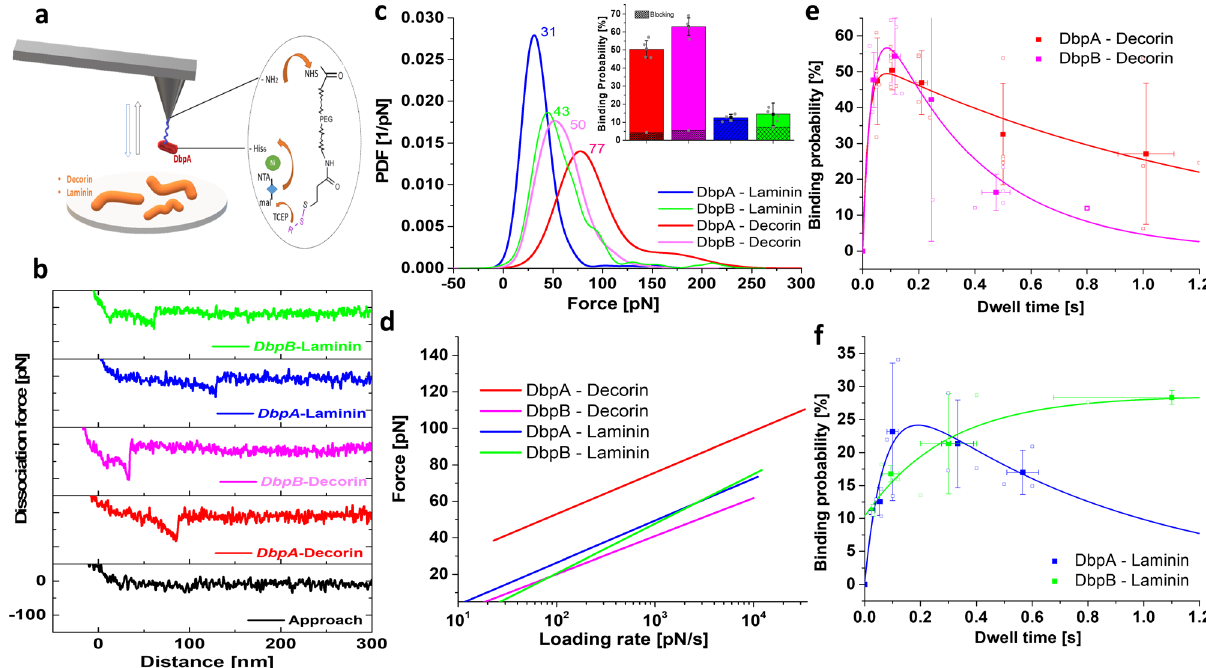
Fig. 3 Single molecular Dbps/ECM bond analysis reveals force-tuned dissociation paths. a Scheme of the immobilization strategy of decorin binding protein coupled to an amino-functionalized AFM tip end via a heterobifunctional PEG linker, and attachment of extracellular matrix protein onto a silicon substrate. b typical force – distance curves obtained by SMFS, from which the dissociation forces (visible as spike at about 50 – 150 nm distance) of individual Dbps/ECM bonds were measured. Dissociation occurred at different distances, re fl ecting variable stretching lengths of decorin or laminin. c Force distributions depicted as experimental probability density functions (PDFs) were constructed from adding dissociation forces represented by Gaussians of unitary area with widths σ representing the measurement noise (cantilever thermal fl uctuation). For each PDF at least 1000 force measurements were recorded at a retraction velocity of 1000 nm/s. PDFs are equivalents to continuos histograms with their maxima being the most probable dissociation forces (see indicated numbers in graph) their uncertainties (widths) re fl ecting the stochastic nature of the dissociation process. Inset. Binding probabilities (from n = 5000 force – distance cycles for each condition, 3 – 5 different tips), calculated as percentages of force – distance cycles monitoring dissociation forces out of the overall force – distance cycles performed, determined at a tip-surface dwell time of ~0.05 s. After addition of blocking agents (Dbps) into the bath solution, the binding probability dramatically decreased to around 5%, evidencing that binding was of speci fi c nature. d dissociation force vs. force loading rate for single Dbps/ECM bonds, i.e., DbpA/decorin, DbpB/decorin, DbpA/laminin, DbpB/laminin. A maximum likelihood approach was used to fi t the data and to extract the kinetic off-rate constant ( K off ) and the length of the dissociation path ( X β ) (see Table 1), using the equation of Bell and Evans 24,25 (original data and fi ts are shown in Supplementary Fig. 2), e , f binding probability assay (BPA). Dbps/ECM bond formation as a function of the dwell time, e DbpA/decorin and DbpB/decorin, f DbpA/laminin and DbpB/laminin.